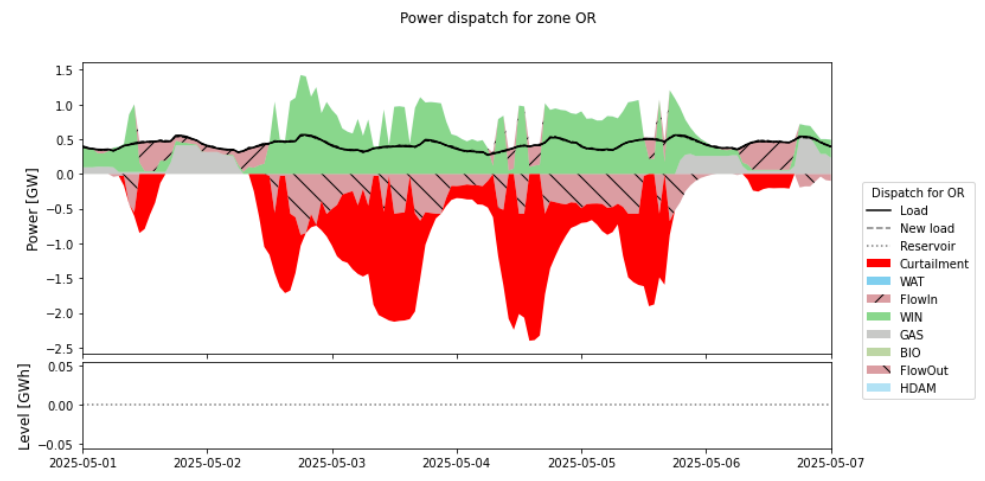
Figure 32. Very-High-Penetration Scenario 10(NH)—Oriental zone (1–7 May 2025).